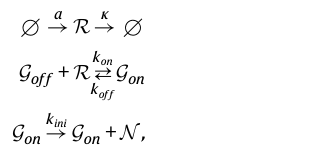
Fig. 2 | Summary of the qualitative behavior of the Γ -OU and CIR models. a Qualitative behavior can be visualized in a two-dimensional parameter space, with κ /( κ + β + γ )ononeaxisandthegainratio θ /( θ + a )ontheother.Thefourlimits discussedin the text correspond to the four cornersofthis space. When a ≫ θ , we obtain Poisson-like behavior (green). When a ≪ θ , we obtain overdispersed dis- tributions(orange). b Dynamicsoflimitingmodels.The Γ -OUandCIRmodelswere simulated using four parameter sets close to the limiting regimes; transcription rates arevisualizedusingtrajectories and cellcartoons, wheretranscription rate is a logarithmic function of cell color. Ten thousand samples from the joint RNA